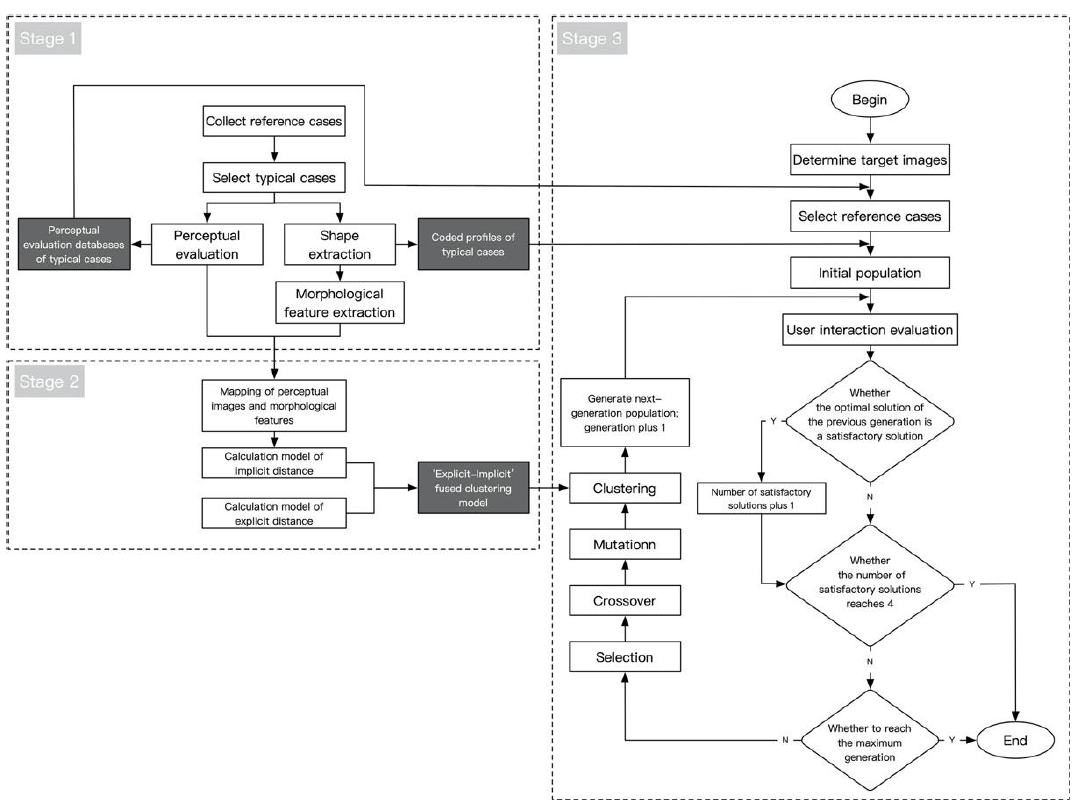
Figure 3. Methodology flow chart.